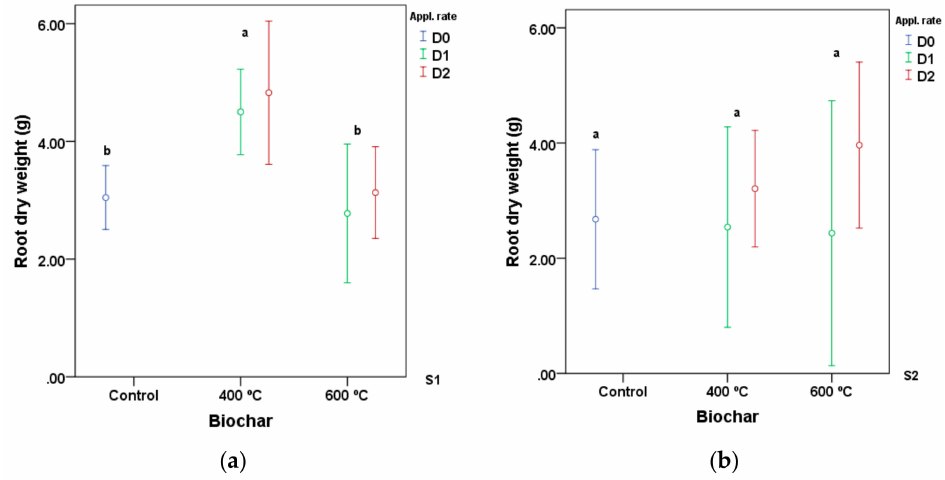
Figure 2. Main value and confidence interval at 95% of root dry weight on the second cycle of a sorghum crop under di ff erent application rates of biochar at 400 ◦ C and 600 ◦ C ( a ) total root dry weight in the growing substrate with the sandy-loam component—S1, ( b ) total root dry weight in clay-loam—S2. Di ff erent letters indicate significant di ff erences ( p < 0.05; Tukey’s test).